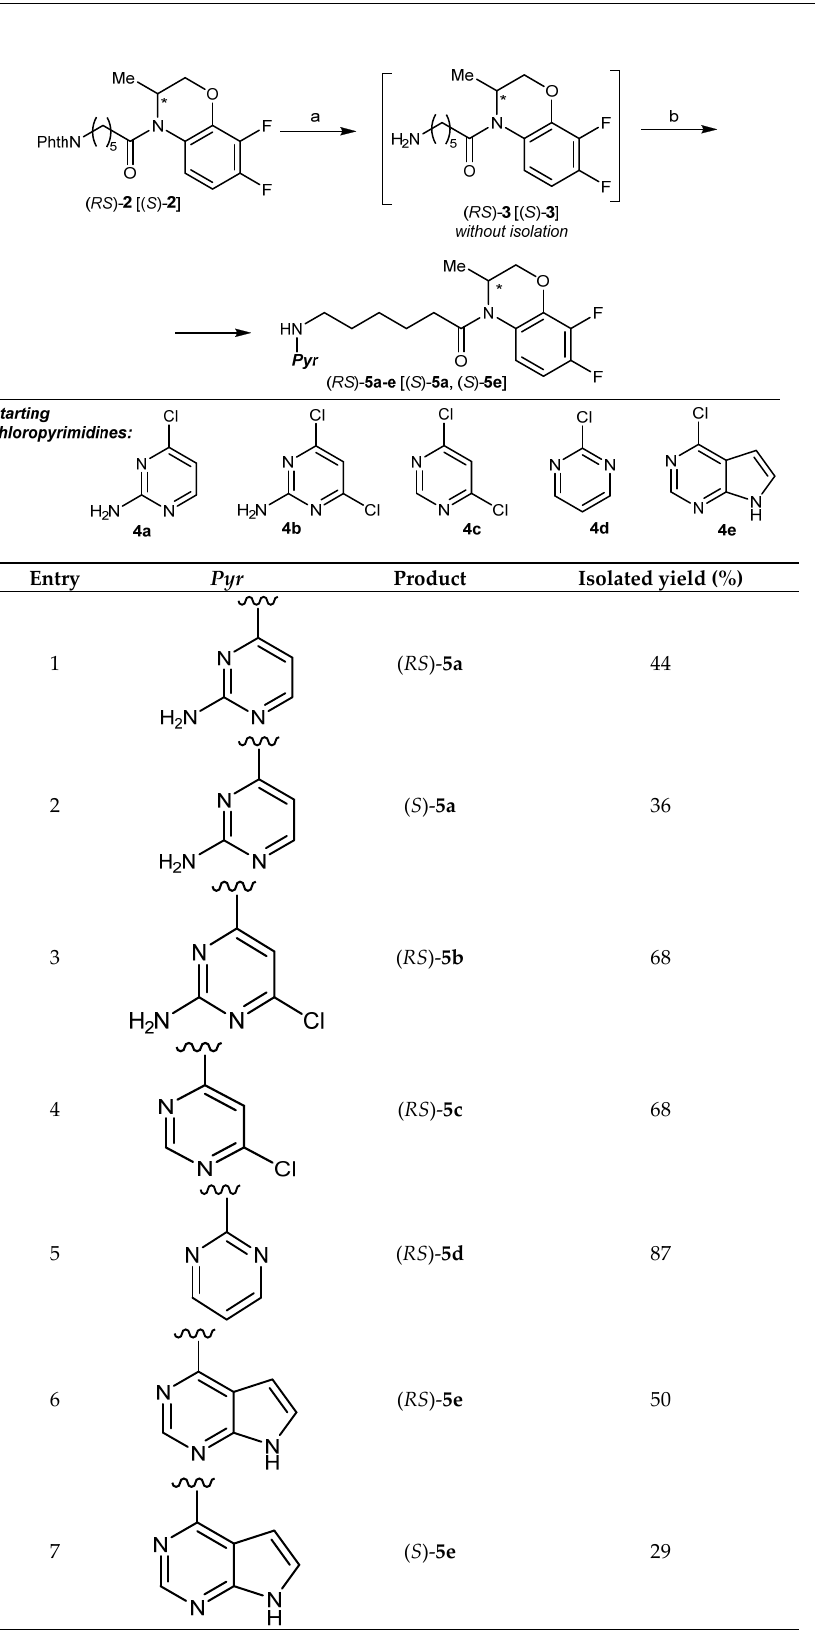
3 of 11 Figure 2. Structures of the previously obtained purine conjugates with N -heterocycles. In this work, in order to elucidate the role of the purine fragment in the antiviral activity exhibited by the lead compound, we synthesized a series of derivatives, in which the purine fragment was replaced by a pyrimidine one, and studied the antiviral activity of the synthesized compounds against HSV-1 and influenza A (H1N1) virus. 2. Results and Discussion 2.1. Chemistry To obtain the target pyrimidine conjugates, we used a synthetic sequence developed earlier for the preparation of purine and 2-aminopurine conjugates [27,30,31]. The starting compounds were amides of N -phthalimidohexanoic acid and racemic